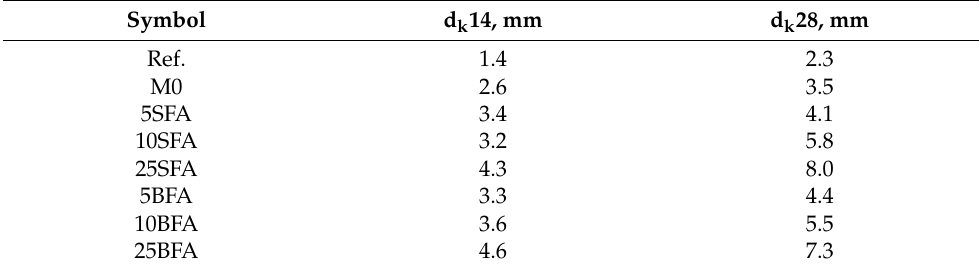
Table 7. Carbonation depth of tested